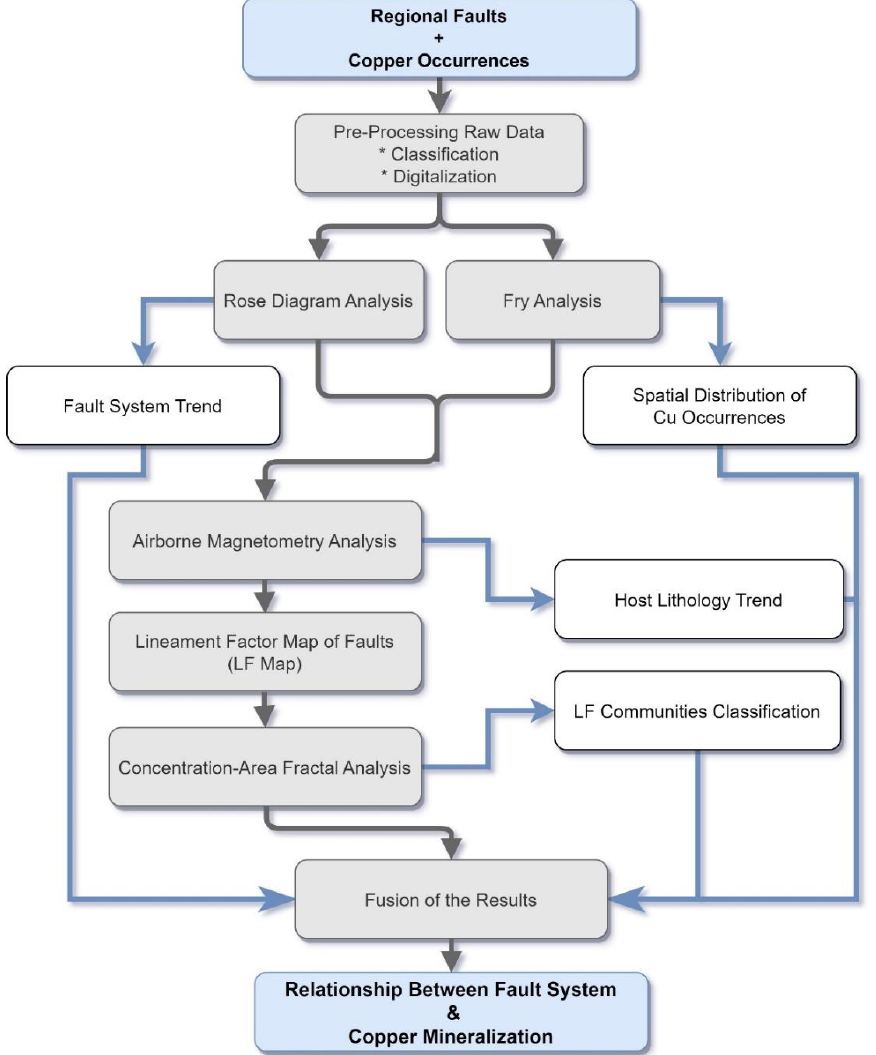
Figure 3. An overview of methodological flowchart used in this